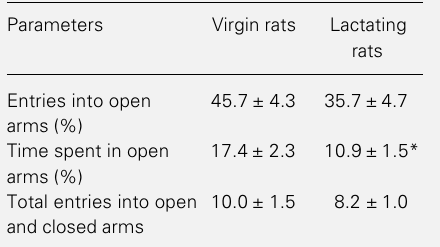
Table 2 - Elevated plus maze behavior of age- matched female virgin (N = 10) and 6th day post- partum lactating (N = 9)